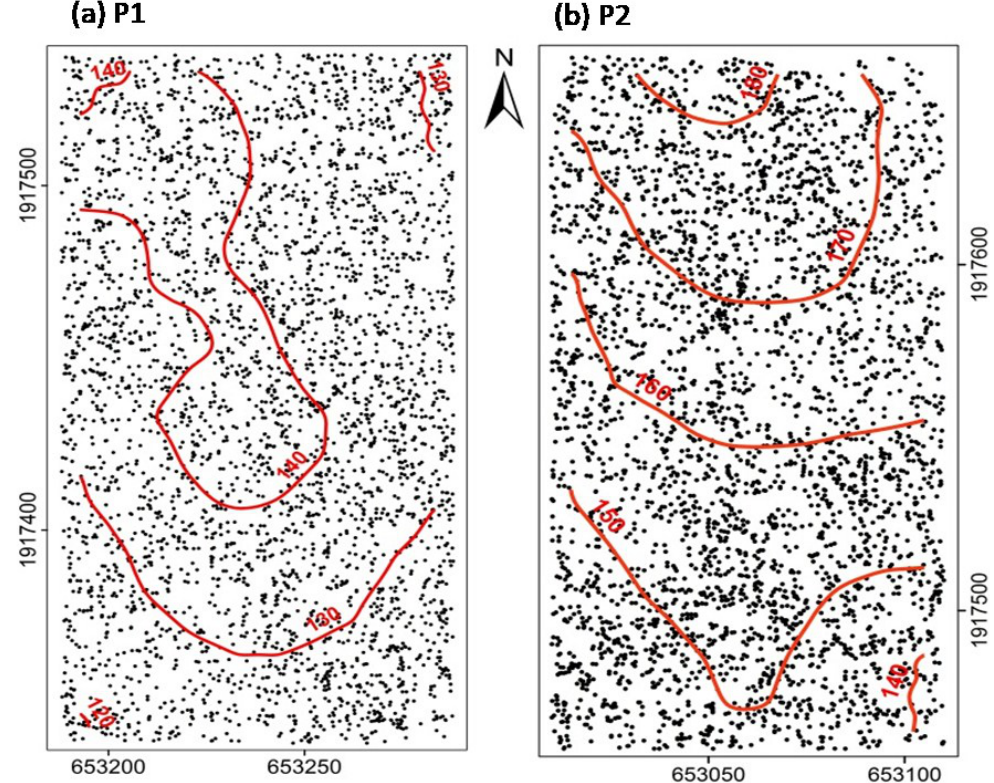
Figure 1. Distribution maps of investigated trees on the two 2-ha plots P1 ( a ) and P2 ( b ) with 10 m contour lines of altitude.